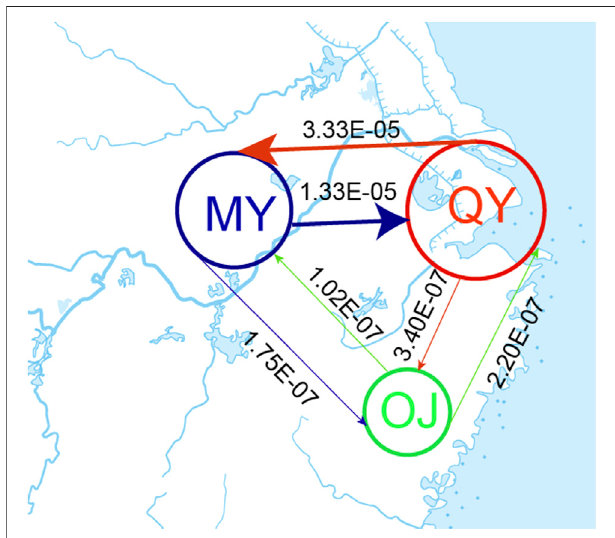
FIGURE 6 | Estimated gene fl ow between adjacent clades. The number on the line showed the strength of gene fl ow. The Oujiang clade (OJ), the Qiantang and lower Yangtze clade (QY), and the middle Yangtze clade